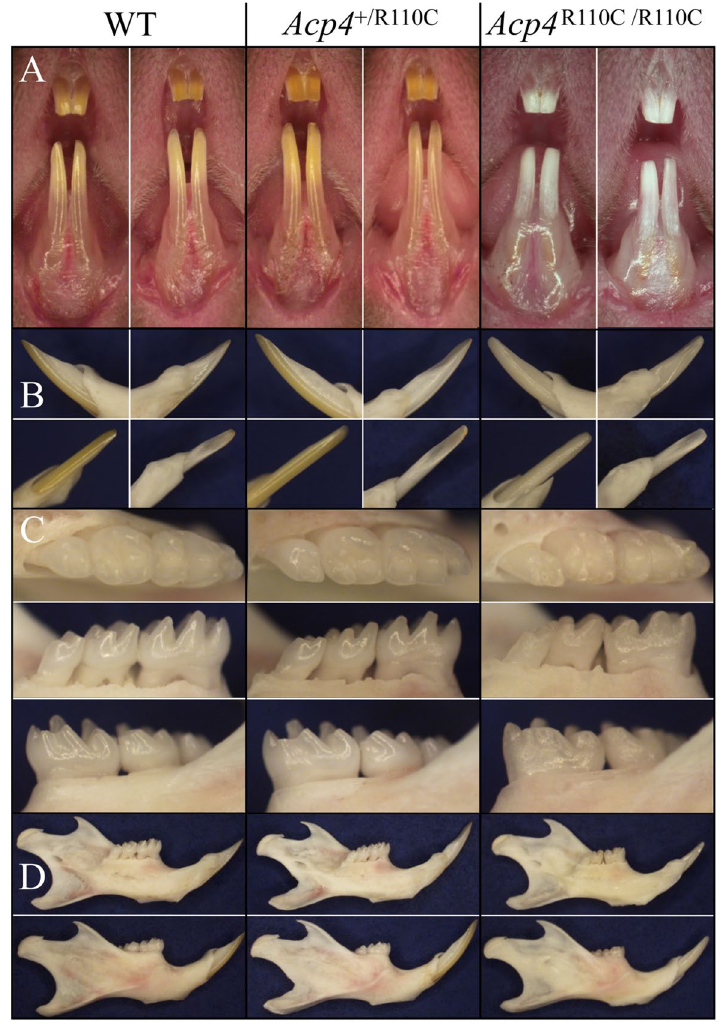
Figure 5. Dental Phenotype of Acp4 +/+ , Acp4 +/R110C , and Acp4 R110C/R110C 7-week-old Mice. There were no appreciable differences in dental phenotype observed between Acp4 +/+ and Acp4 +/R110C mice. ( A ) Frontal view of maxillary and mandibular incisors. The Acp4 R110C/R110C incisors appeared chalky white, and the enamel had abraded from dentin surface down to the cervical region and made the incisors appear shorter. ( B ) Medial (upper left), lateral (upper right), lingual (lower right), and labial (lower left) views of mandibular incisors. The Acp4 R110C/R110C incisal edge was flat and appeared shorter than that of Acp4 +/+ due to attrition and chipping. ( C ) Occlusal (upper), lingual (middle), and buccal (lower) views of mandibular molars. No differences in alveolar bone level were observed among the three genotypes. The Acp4 R110C/R110C molars showed a dull and rough appearance and significant attrition. ( D ) Medial (upper) and lateral (lower) views of the hemimandible. No overt bony abnormality was observed for the Acp4 R110C/R110C